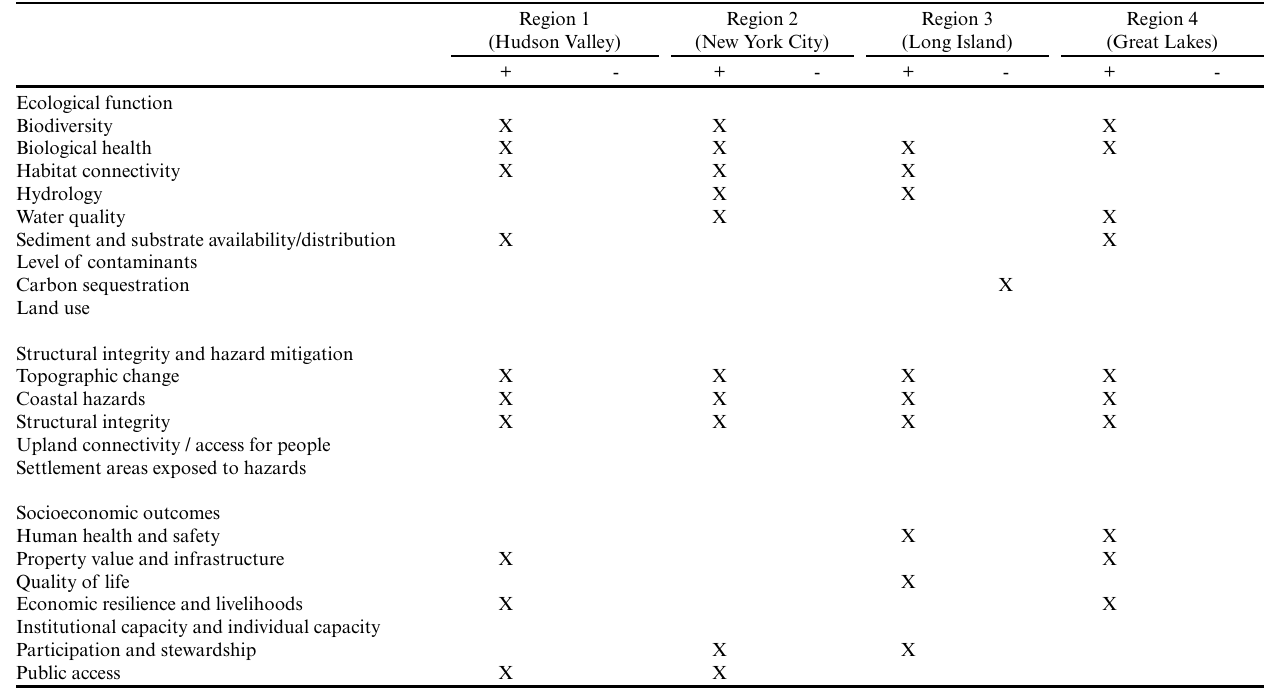
Table 1 . Prioritization of resilience service indicators across four stakeholder regions. This table details the outcomes of a dot voting exercise conducted at each of the regional work groups. Each participant was given 20 dots that could be used to indicate support for (+) or against (-) each performance parameter across all three resilience areas: ecological function, structural integrity and hazard mitigation, and socioeconomic outcomes. The top 10 parameters with the most votes for or against it within each regional work group are marked with an